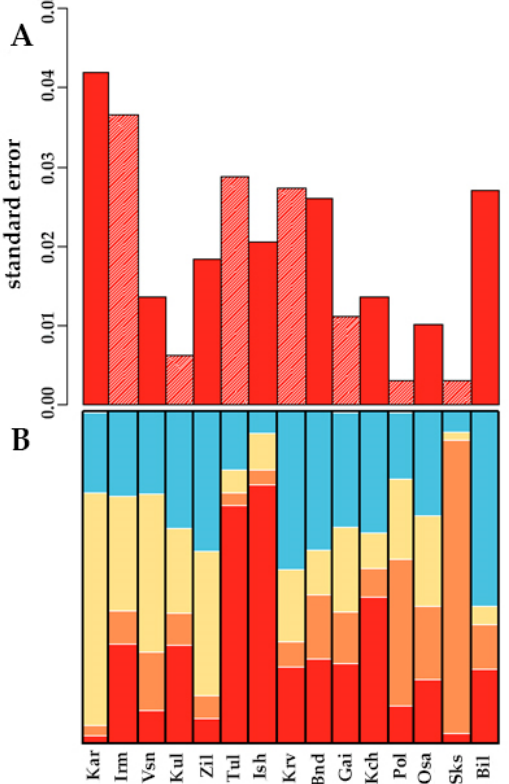
Figure 3. Standard error of calculating genetic structure ( A ) and genetic structure of populations ( B ). Each colour represents genotypes by sample.